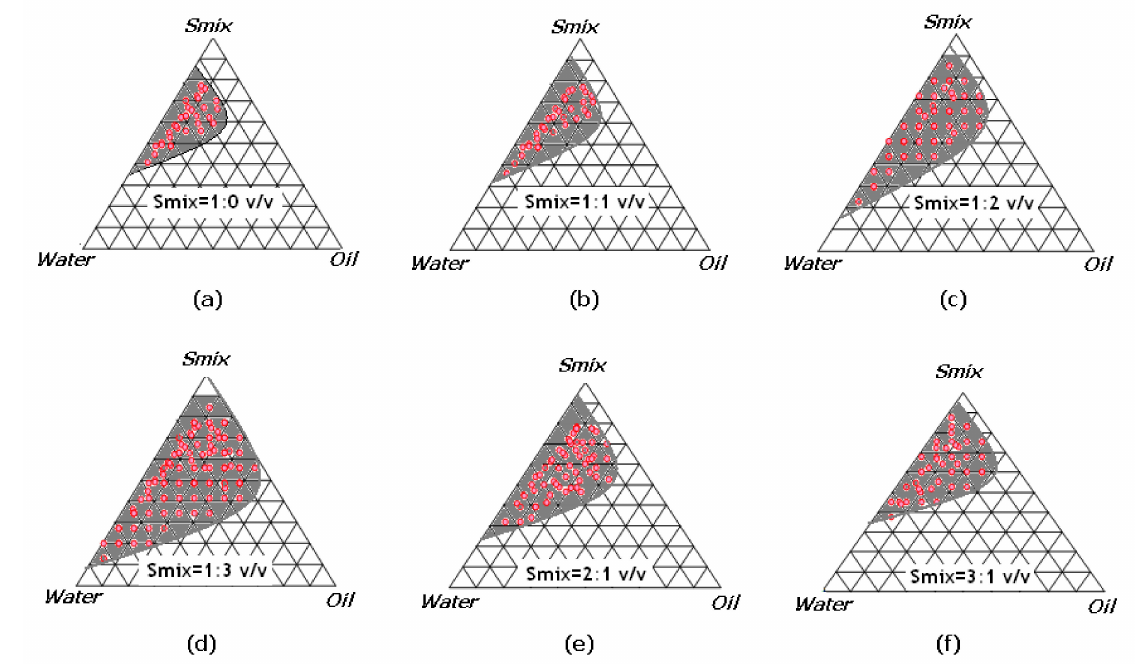
Figure 1. Nanophasic maps (shaded area) for oil (niouli essential oil (NEO)), surfactant (Kolliphor EL), and cosurfactant (Carbitol) at different S mix ratios (Figure 1( a ) (1:0), ( b ) (1:1), ( c ) (1:2), ( d ) (1:3), ( e ) (2:1), and ( f ) (3:1)).